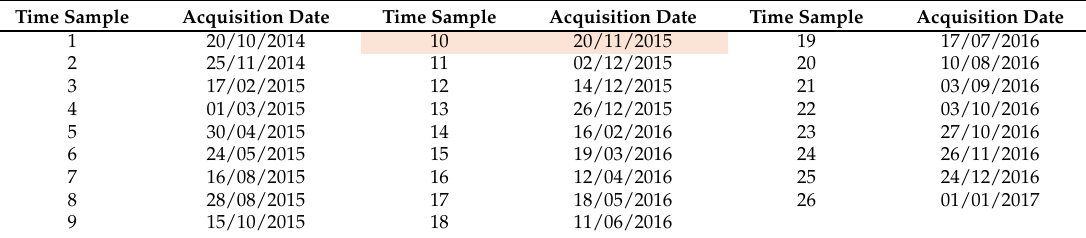
Table 2. The acquisition dates for the Sentinel-1 image time series. Master acquisition